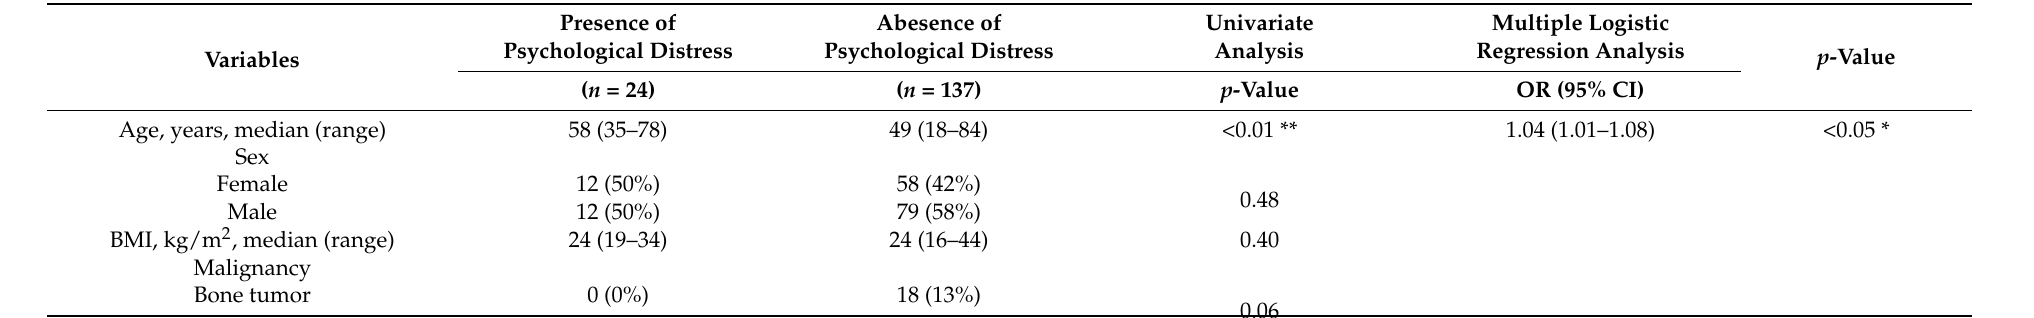
Table 6. Univariate and multivariable logistic regression of risk factors related to psychological distress in patients with benign bone and soft tissue tumors.